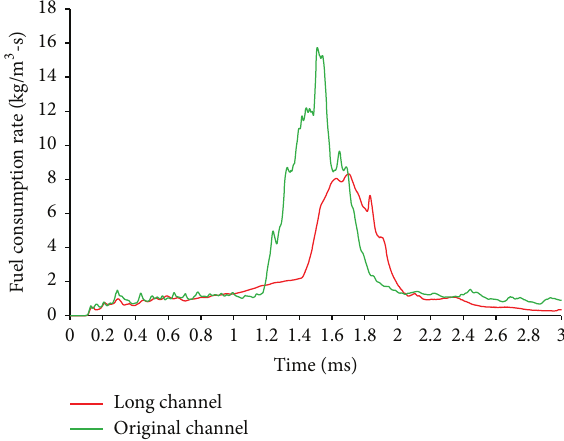
Figure 14: Fuel consumption rate for original CVC chamber and extended CVC